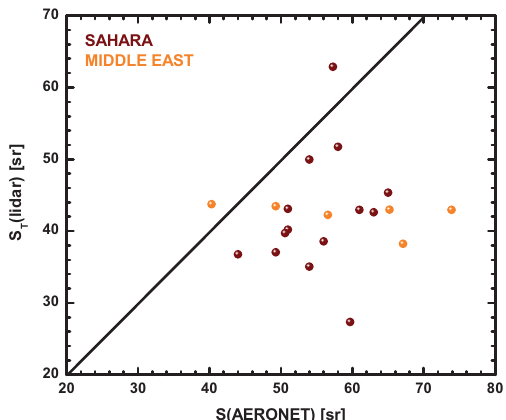
Figure 12. Lidar-derived total tropospheric lidar ratio S T vs. respec- tive AERONET-derived lidar ratio S A after Schuster et al. (2012). 14 Saharan dust events and 6 Middle East dust cases, observed over Limassol in the 2010–2013 period, could be analyzed. The solid line shows the 1 : 1 correlation